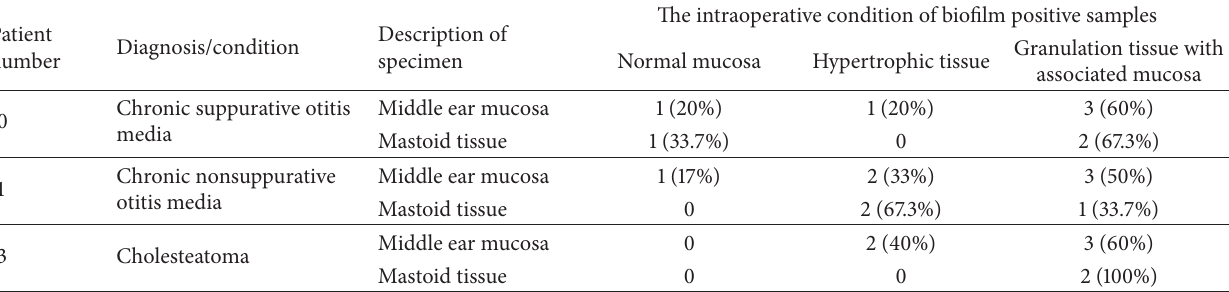
Table 2: The intraoperative condition of biofilm positive samples during the surgery.